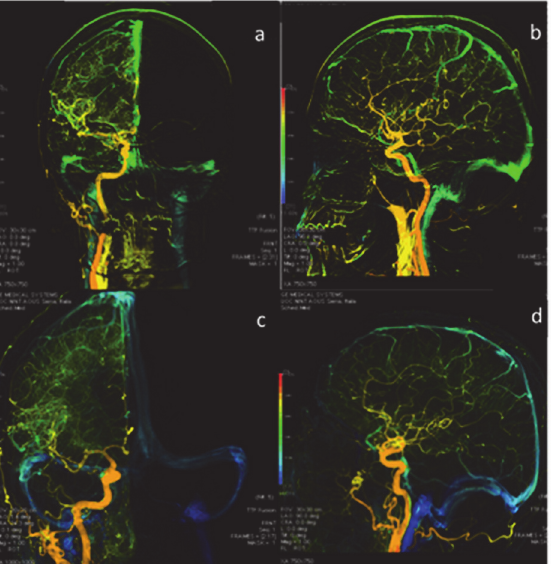
Fig 1. DSA examination: anterior-posterior and lateral views of color-coded right carotid artery of control (a;b) and MS patient (b;c). The blue colour, shown only in MS patients, demonstrates a prolonged CCT. The veins are in green and not blue in the